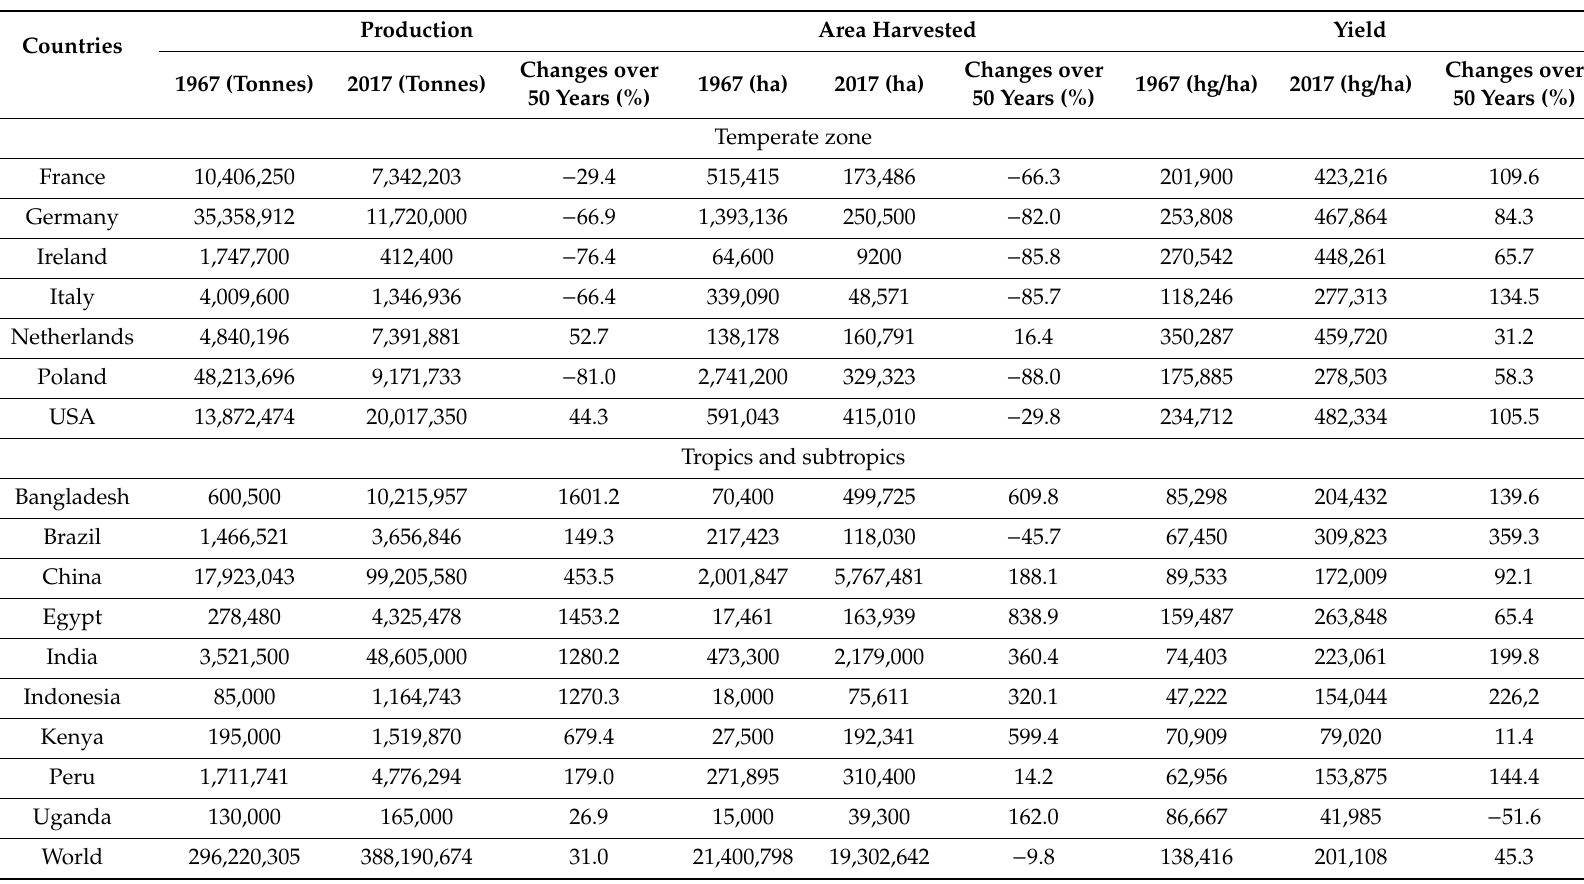
Table 1. Production (in tonnes), area harvested (in ha) and potato yield (in hg / ha) in selected temperate countries and some countries of the tropics and subtropics, as well as changes in production, area harvested and potato yield over 50 years (1967–2017)